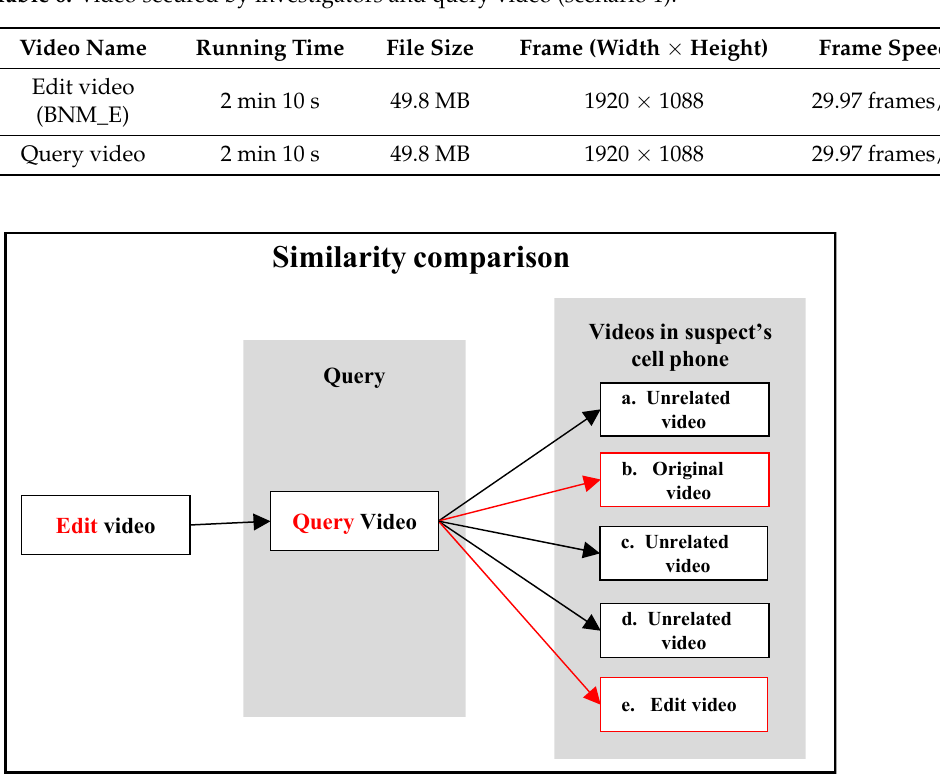
Figure 7. Comparison for scenario 1.